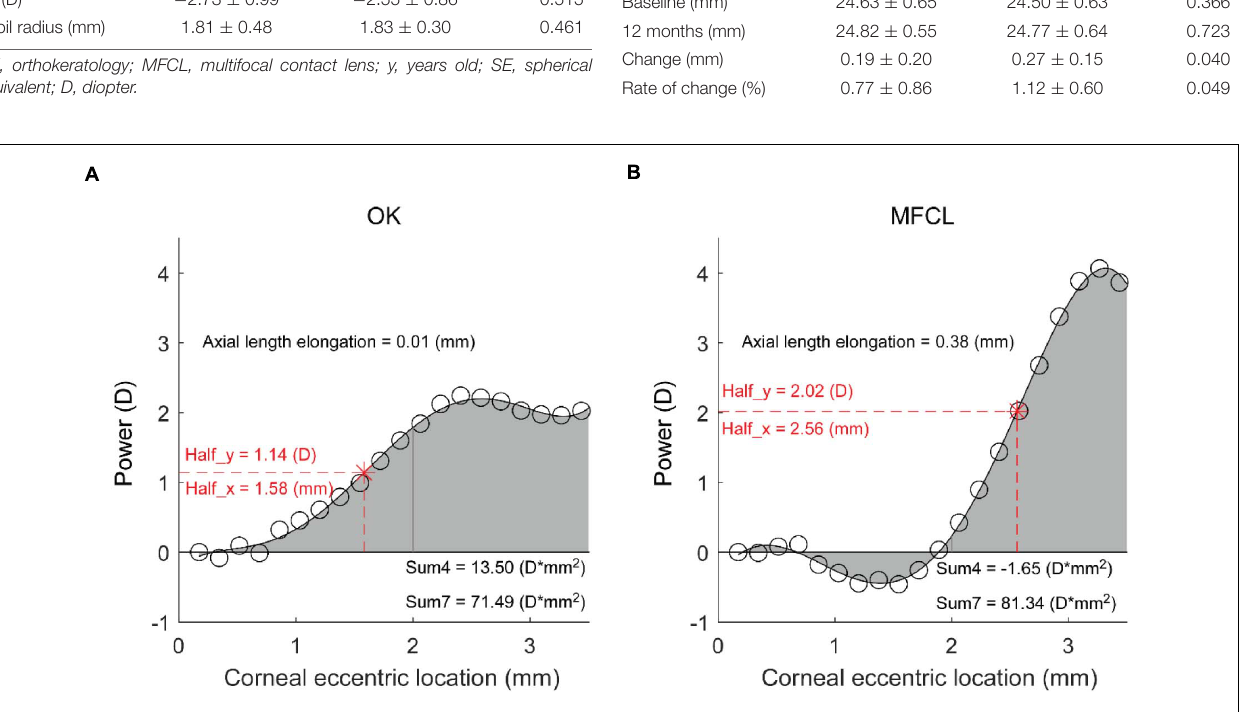
FIGURE 2 | Representative RCRPS profiles. (A) An eye in the OK group. (B) An eye from the MFCL group. RCRPS, relative corneal refractive power shift; D, diopter; OK, orthokeratology; MFCL, multifocal soft contact lens; Half_x, the corneal eccentric location where RCRPS reached the half peak value; Half_y, half of the RCRPS peak value; Sum4, the integrated value of the RCRPS located within an area of 4-mm diameter; Sum7, the integrated value of the RCRPS located within an area of 7-mm diameter.